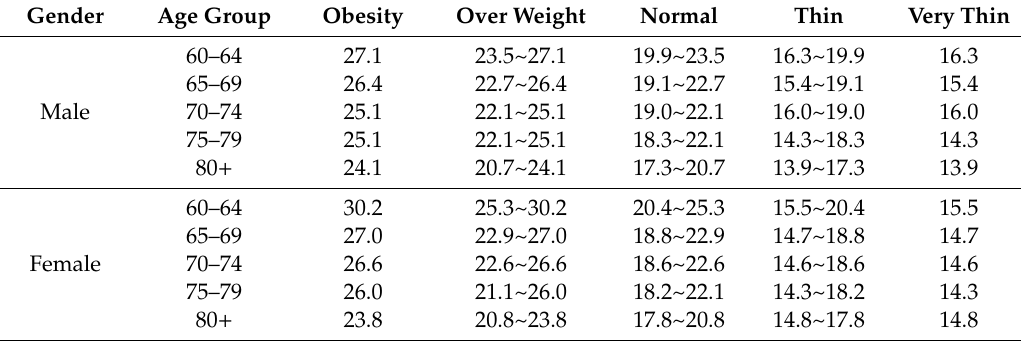
Figure 1. Cajori 5-grade evaluation norms. Table 13. BMI 5-grade relative evaluation norms, Unit: kg / m 2